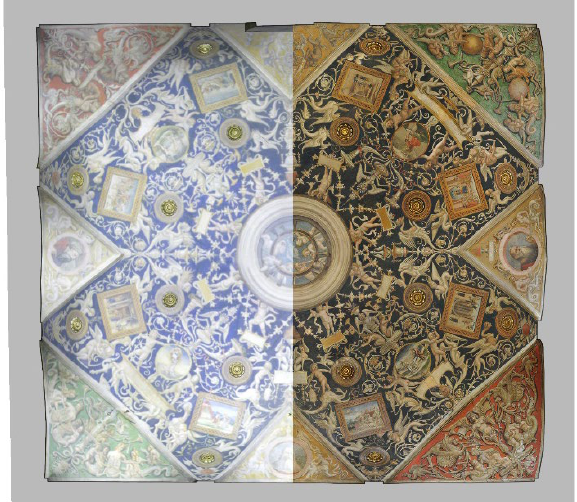
Figure 6 . Plan vault of the chamber frescoed by Araldi (on the left: orthophoto computed using the radiometric information provided by the RTC360 camera; on the right: orthophoto computed using the radiometric information provided by the Nikon